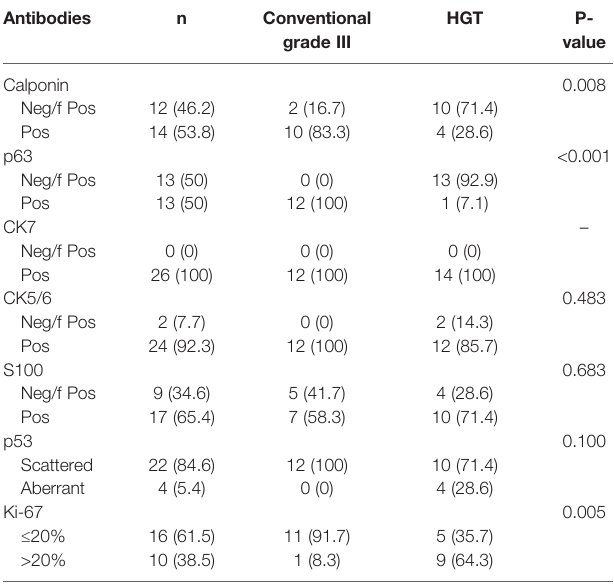
TABLE 3 | Differences in immunophenotypes between conventional grade III and HGT ACC. Antibodies n